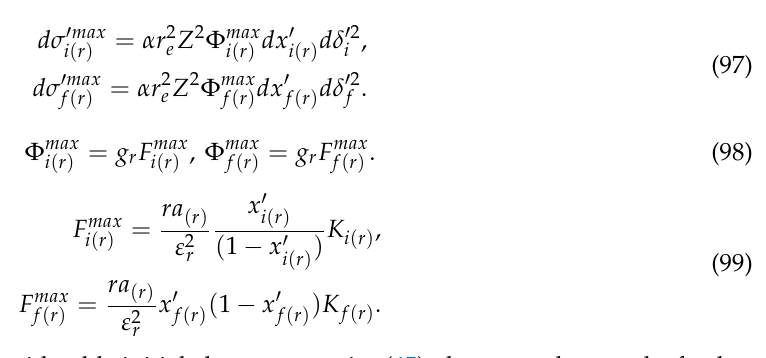
(99) function on parameter δ (cid:48) 2 i ( r ) for the 1, 2, and 3 resonances. The magnitude of the f